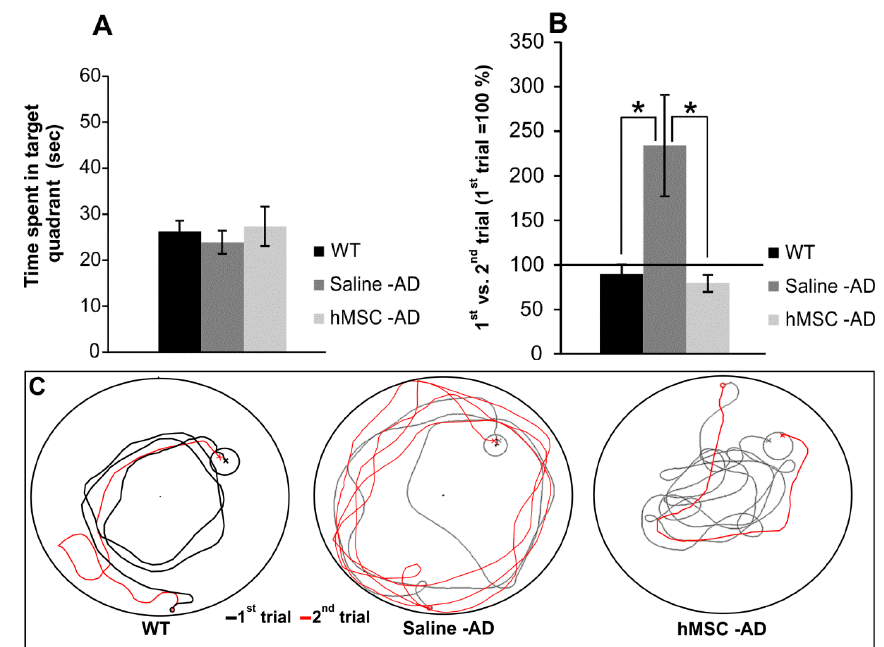
Figure 1. Results from the Morris water maze (MWM) test (probe trial) showing that reference memory was maintained in non-transgenic and transgenic mice at 14 months of age ( A ); In the working memory test, the percentages shown on the y-axis indicate what percent of the time needed to find the hidden platform was saved between the first and second trials; 100% indicates no difference between the two trials ( B ); Illustrative images of mouse trajectories in the MWM during the first and second trials used for working memory assessment ( C ). * p < 0.05. WT: wild-type; AD: Alzheimer’s disease; hMSC: human mesenchymal stem cell.